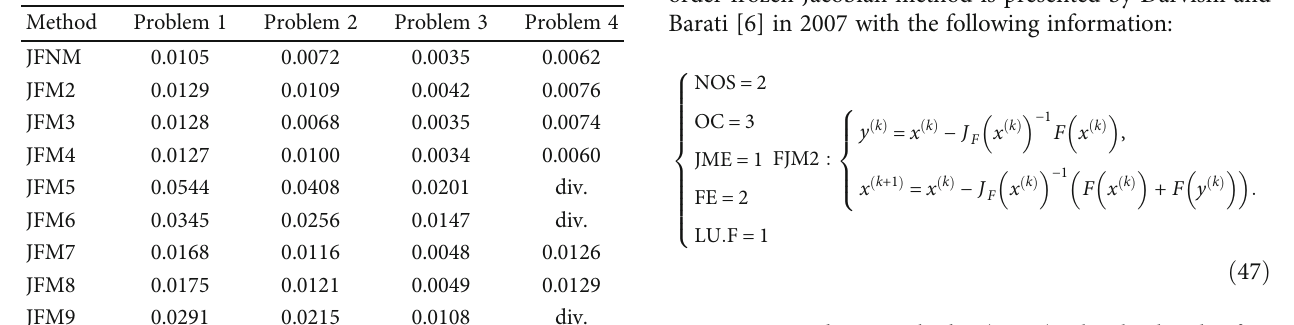
Table 8: Values of JFC2 for case n = 80